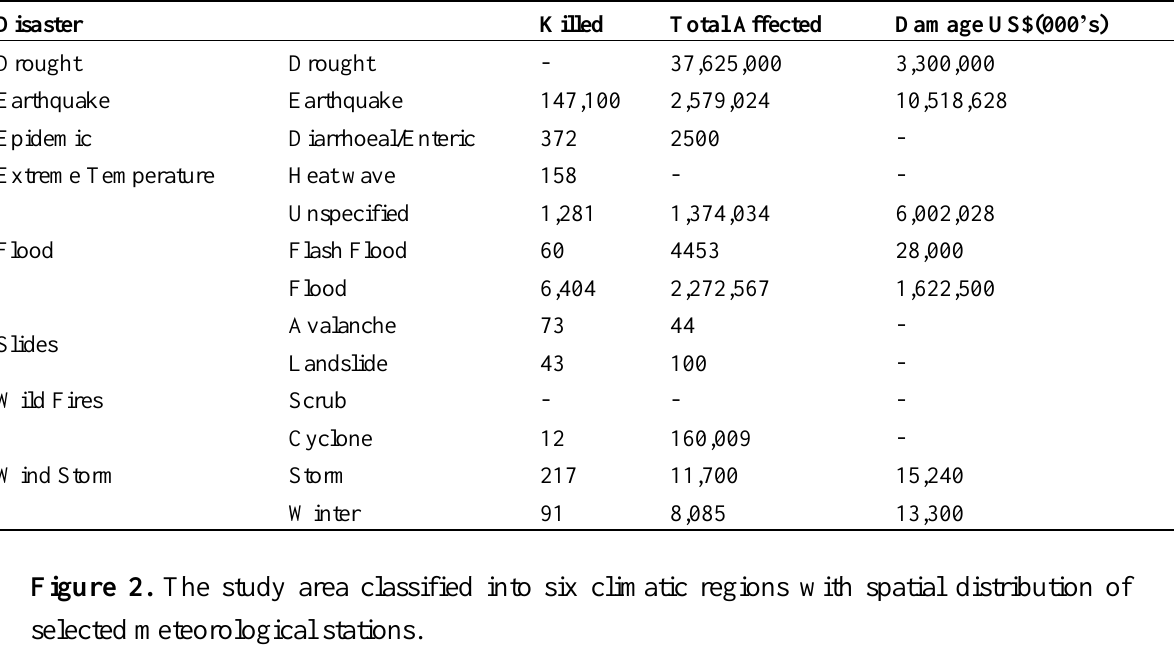
Table 1. Summarized table of natural disasters in Iran from 1900 to 2008.